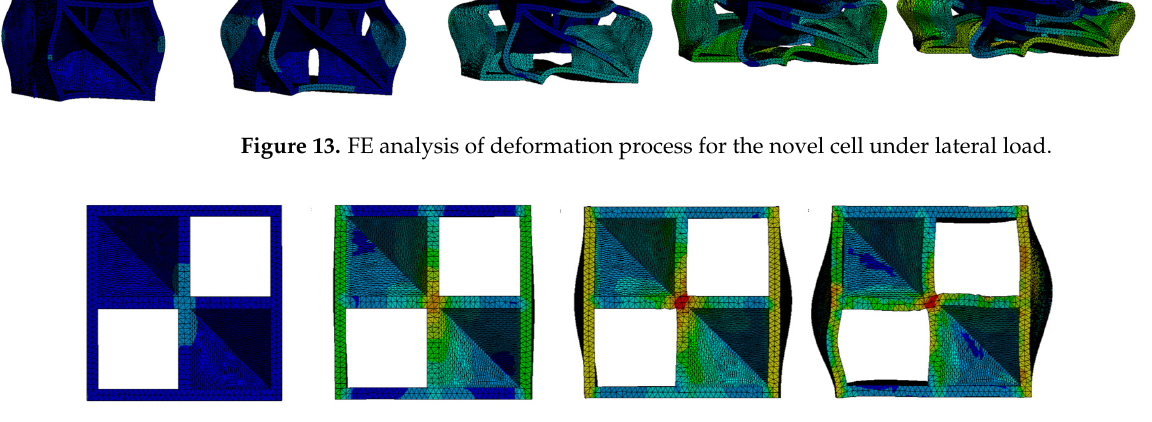
Figure 14. Shear stress concentration at the mid-section of the novel cell.